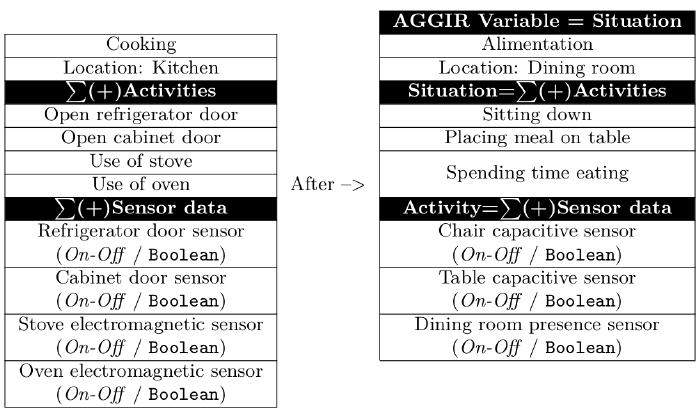
Figure 14. Orchestration of the AGGIR Alimentation Variable.